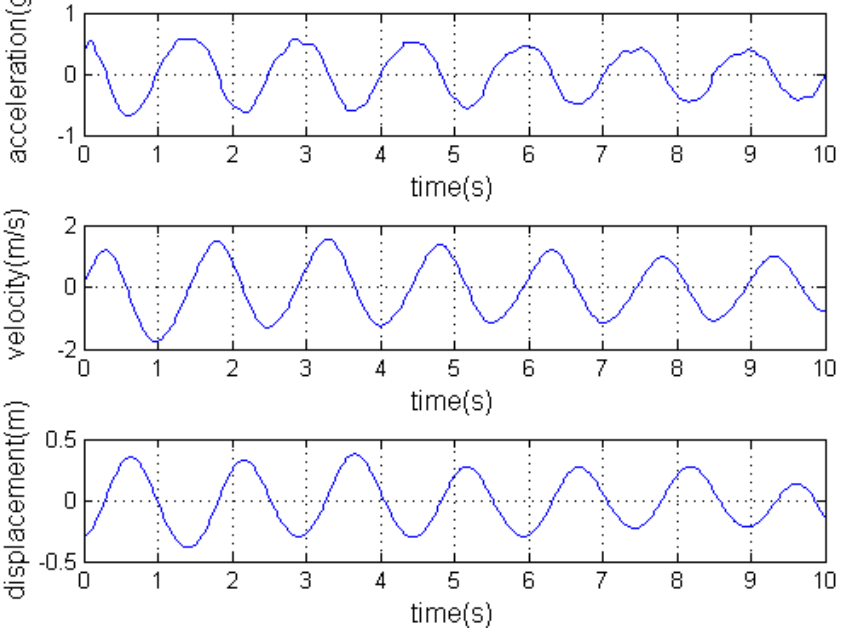
Figure 7. The plots of changing acceleration to displacement.